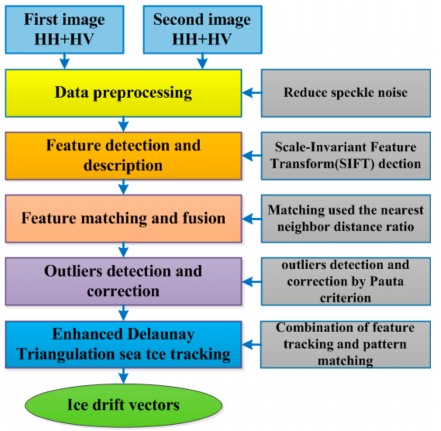
Figure 2. Flowchart of the sea ice drift retrieval